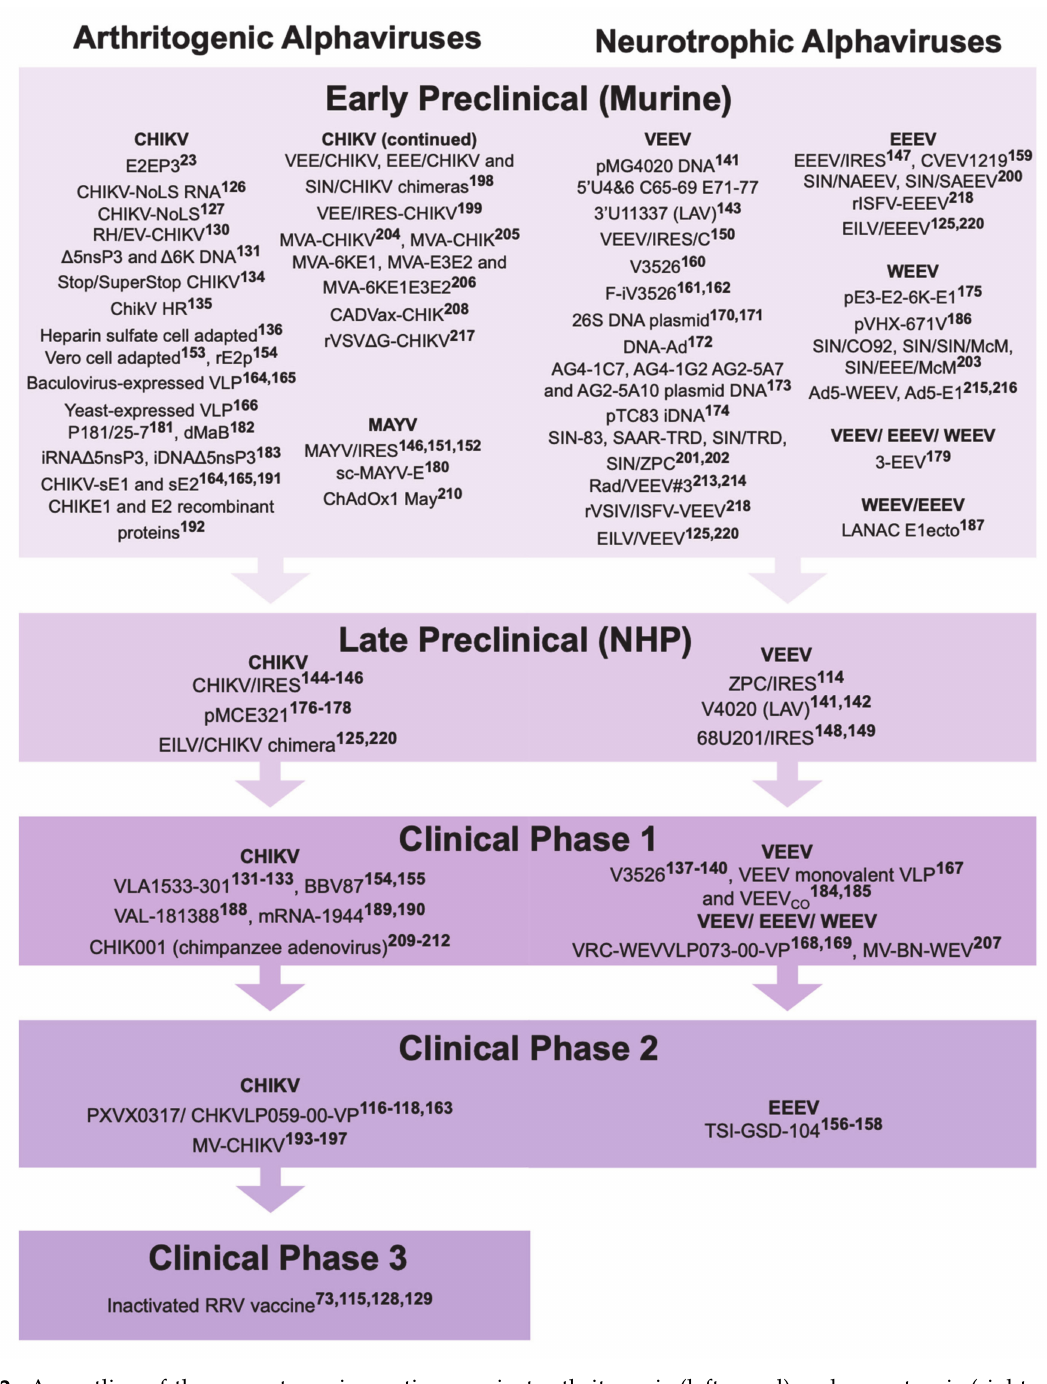
Figure 2. An outline of the current vaccine options against arthritogenic (left panel) and neurotropic (right panel) al- phaviruses. Most of these vaccine candidates are currently under preclinical testing (early preclinical—vaccine candidates tested in mouse models; late preclinical—vaccine candidates currently under testing in non-human primates (NHP)), while a minority of them are currently undergoing clinical trials (Phase 1, 2 or 3). LAV; live-attenuated virus; VLP, virus-like particle; SIN, Sindbis virus; ISFV, Isfahan virus; May, Mayaro virus; EILV, Eilat virus, VSV/VSIV, vesicular stomatitis virus; MV, measles virus; MVA, modified vaccinia virus Ankara. Data curated from literature reported through February 2021. Numbers in superscript refer to reference numbers (See Reference list